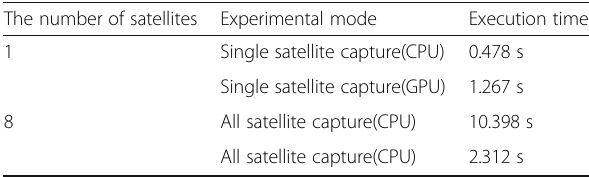
Table 3 Time consuming comparison between GPU and CPU The number of satellites Experimental mode Execution